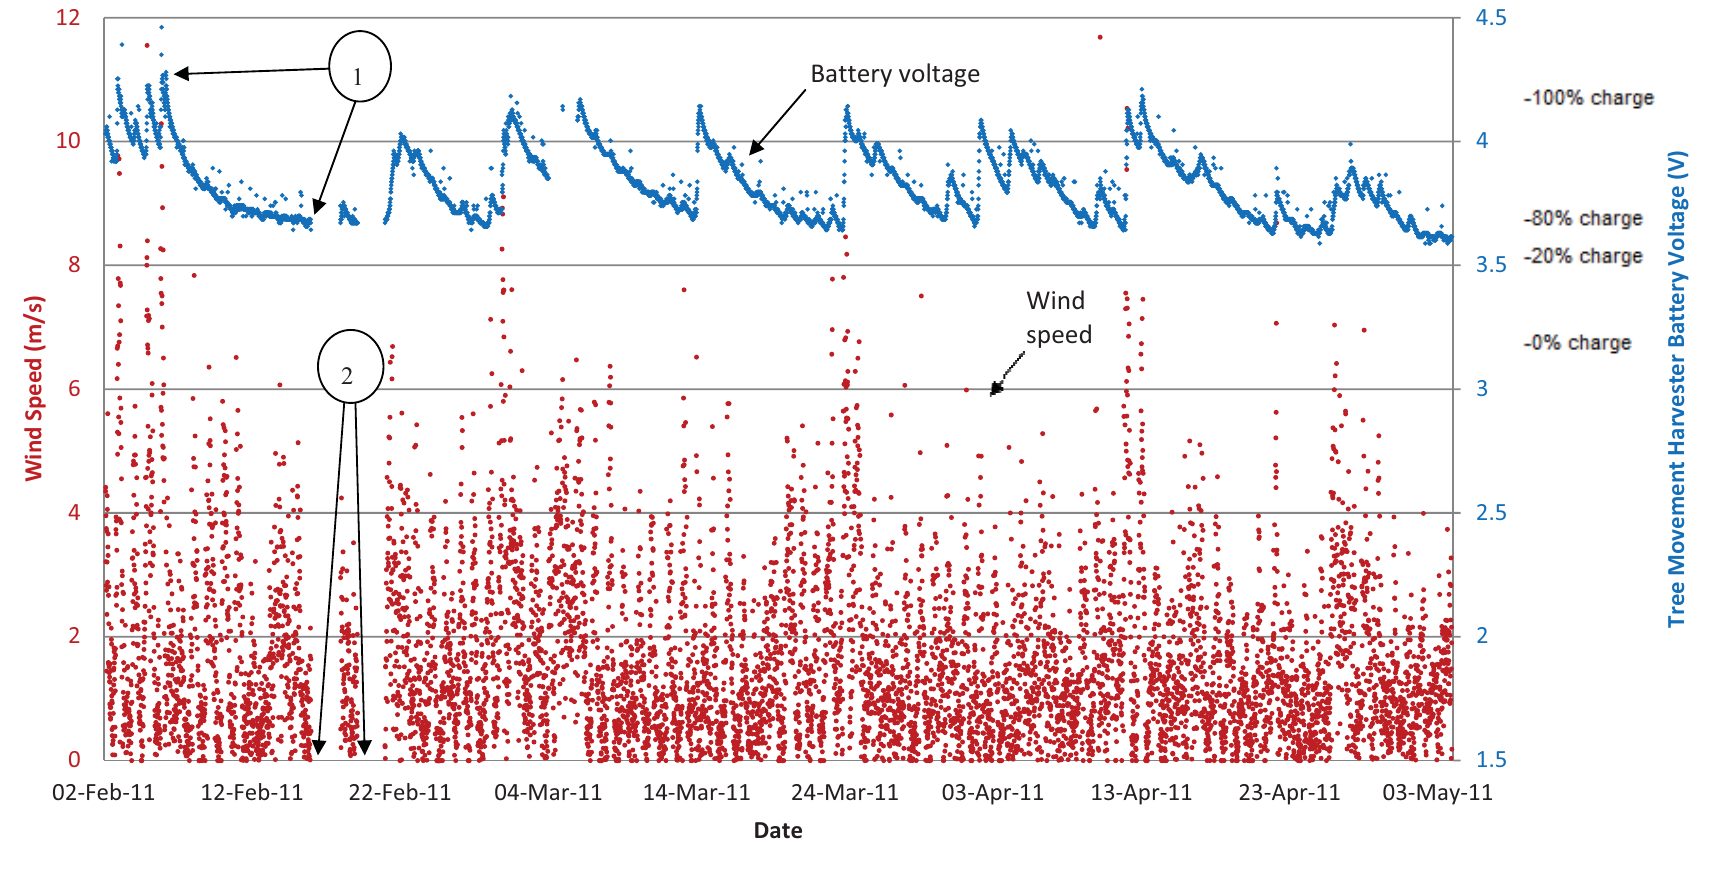
Figure 8. Tree powered sensor node battery voltage and wind speed; representative sample, February to May